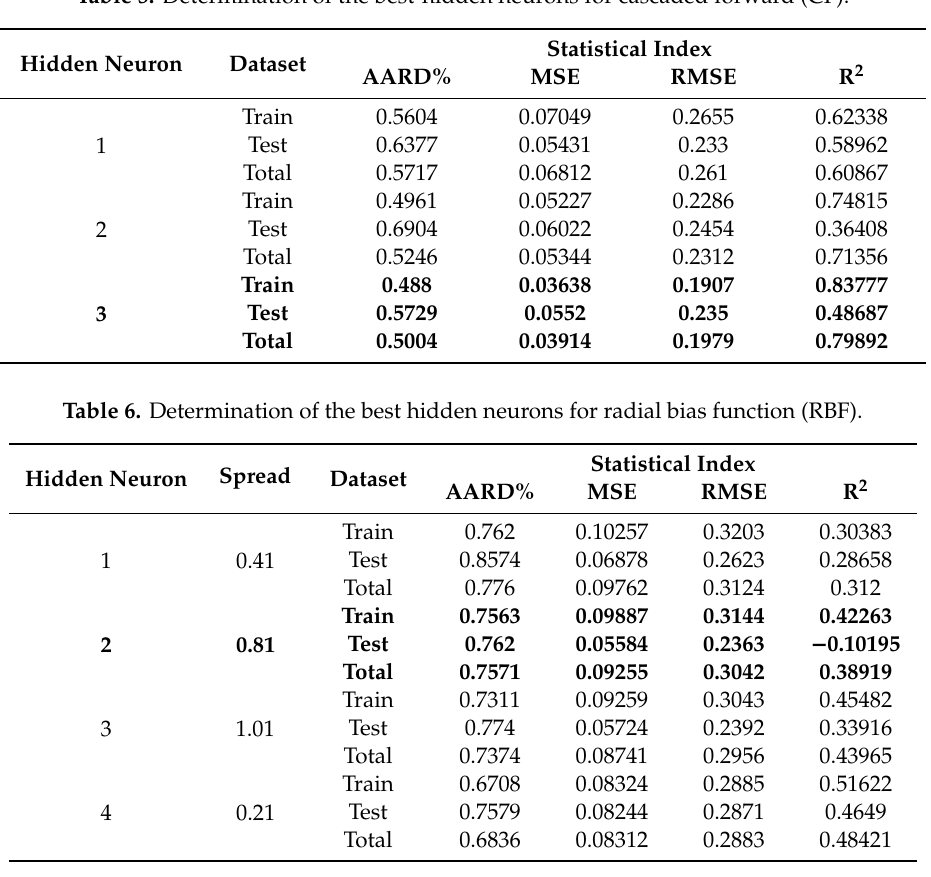
Table 5. Determination of the best-hidden neurons for cascaded forward (CF).